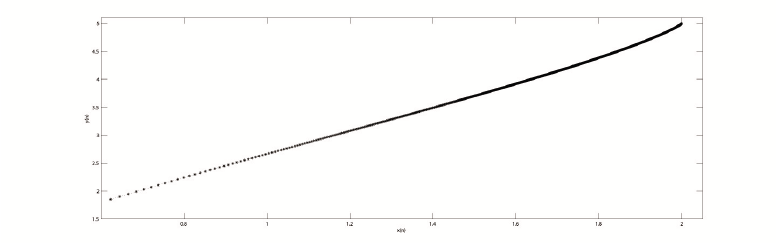
Figure 1. The stability of equilibrium of (1.4) while α i > β